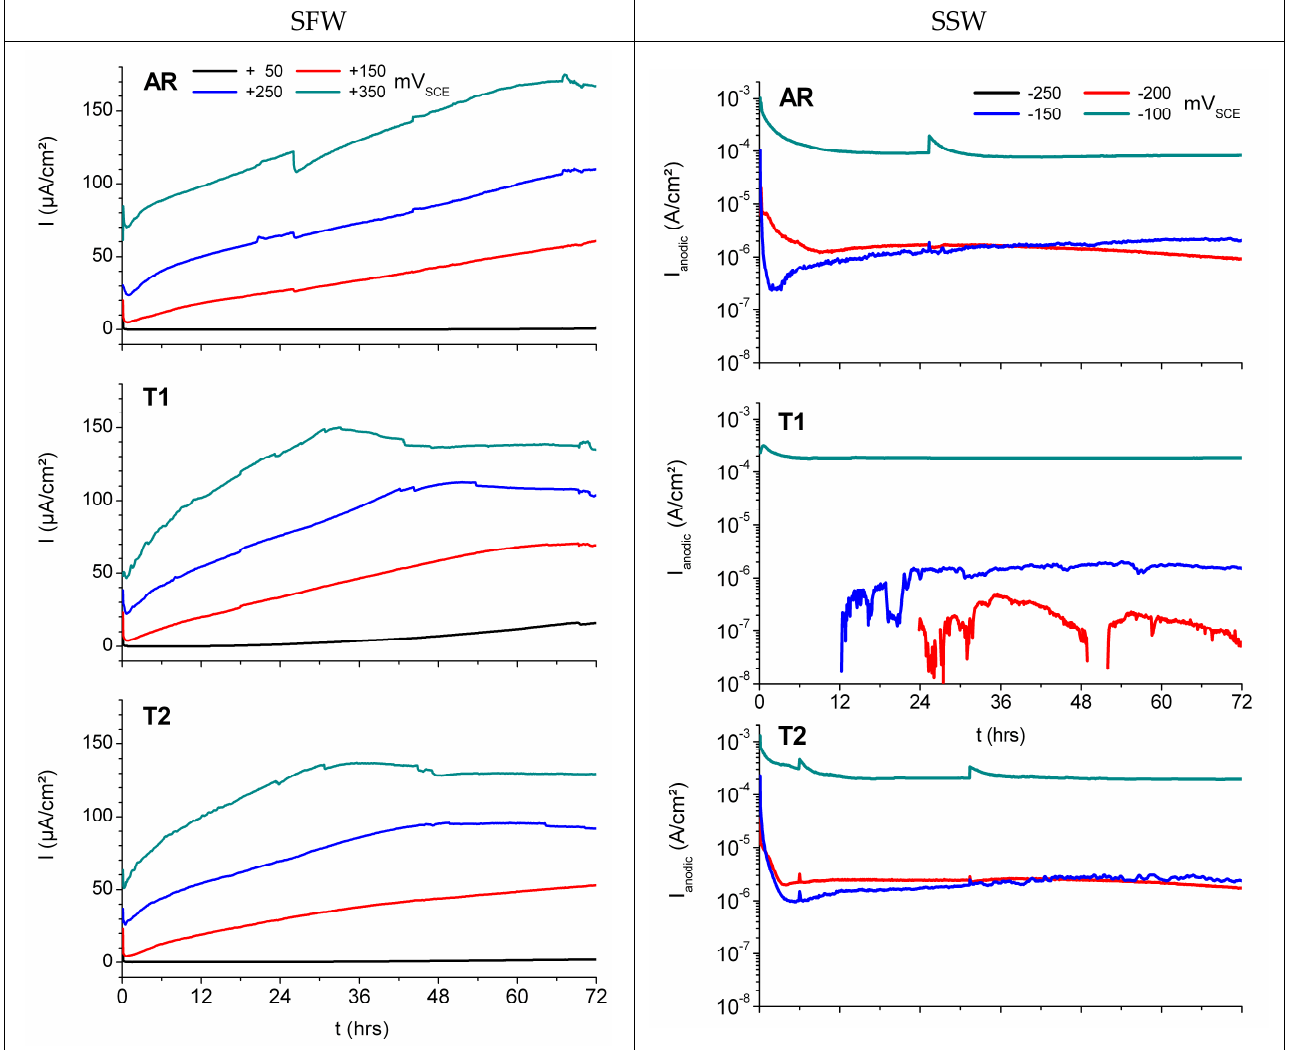
Figure 7. Effect of electrolyte and potentials on potentiostatic corrosion testing of NAB in SFW (plotted with linear scaling) and SSW (plotted with semilog scaling).